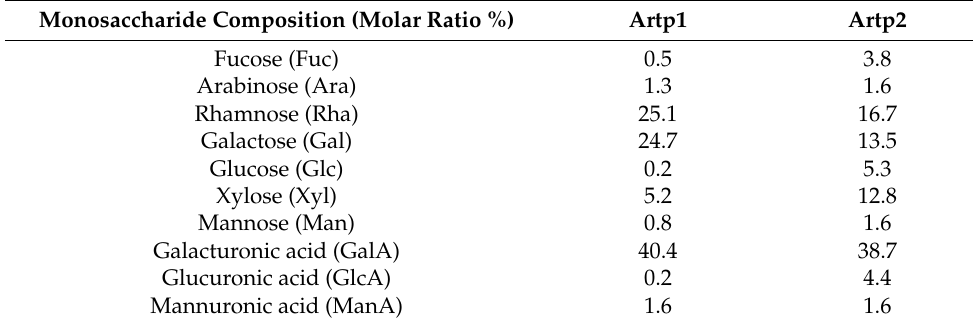
Table 3. The monosaccharide compositions of Artp1 and Artp2. Monosaccharide Composition (Molar Ratio